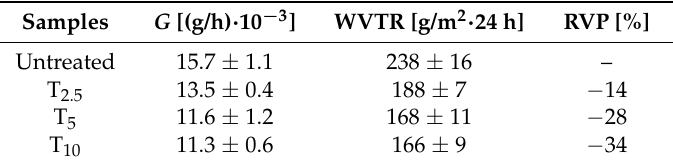
Table 3. Water vapour flow rate ( G ), water vapour transmission rate (WVTR), and reduction of the vapour permeability (RVP). Standard deviations are also